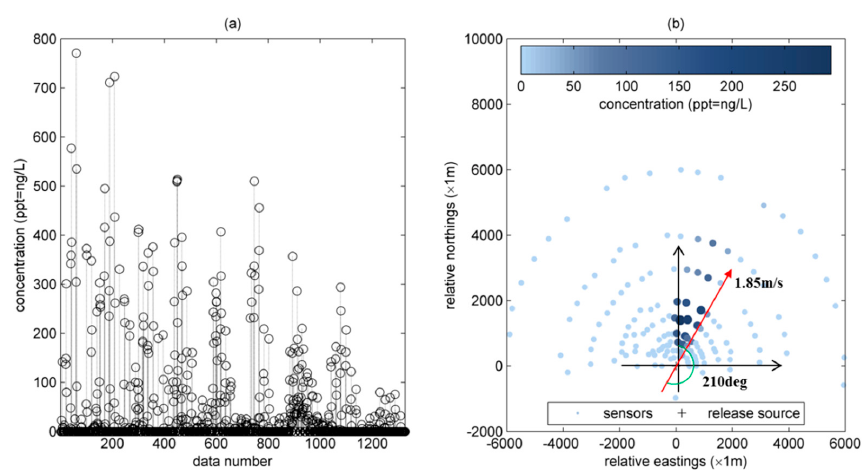
Figure 2. SF6 concentration data at 20 September. ( a ) 1326 concentration records; ( b ) distribution of monitoring stations and concentration distribution at 10:00).